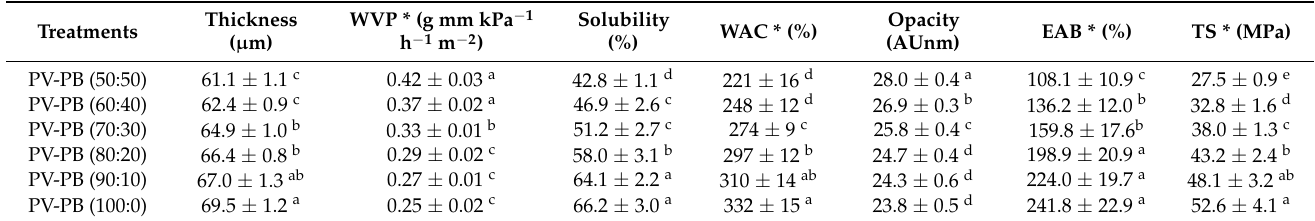
Table 1. Various physical and mechanical attributes of PVA-PBS composite